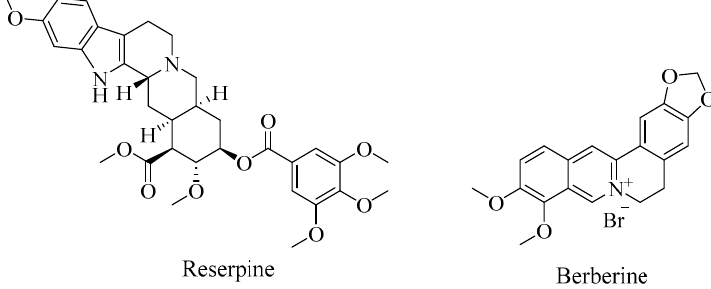
Figure 4. Chemical structures of the plant-derived alkaloids, reserpine and berberine.